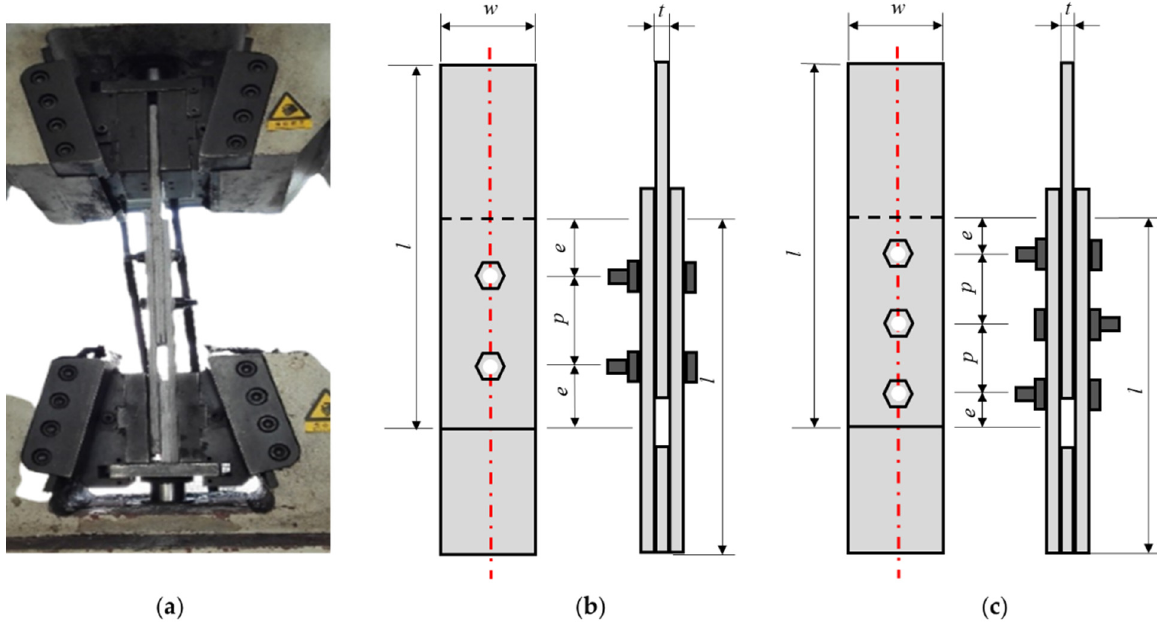
Figure 3. Double-lap shear test setup and geometric configuration of specimens: ( a ) actual photo, ( b ) specimen with two bolts, and ( c ) specimen with three bolts .